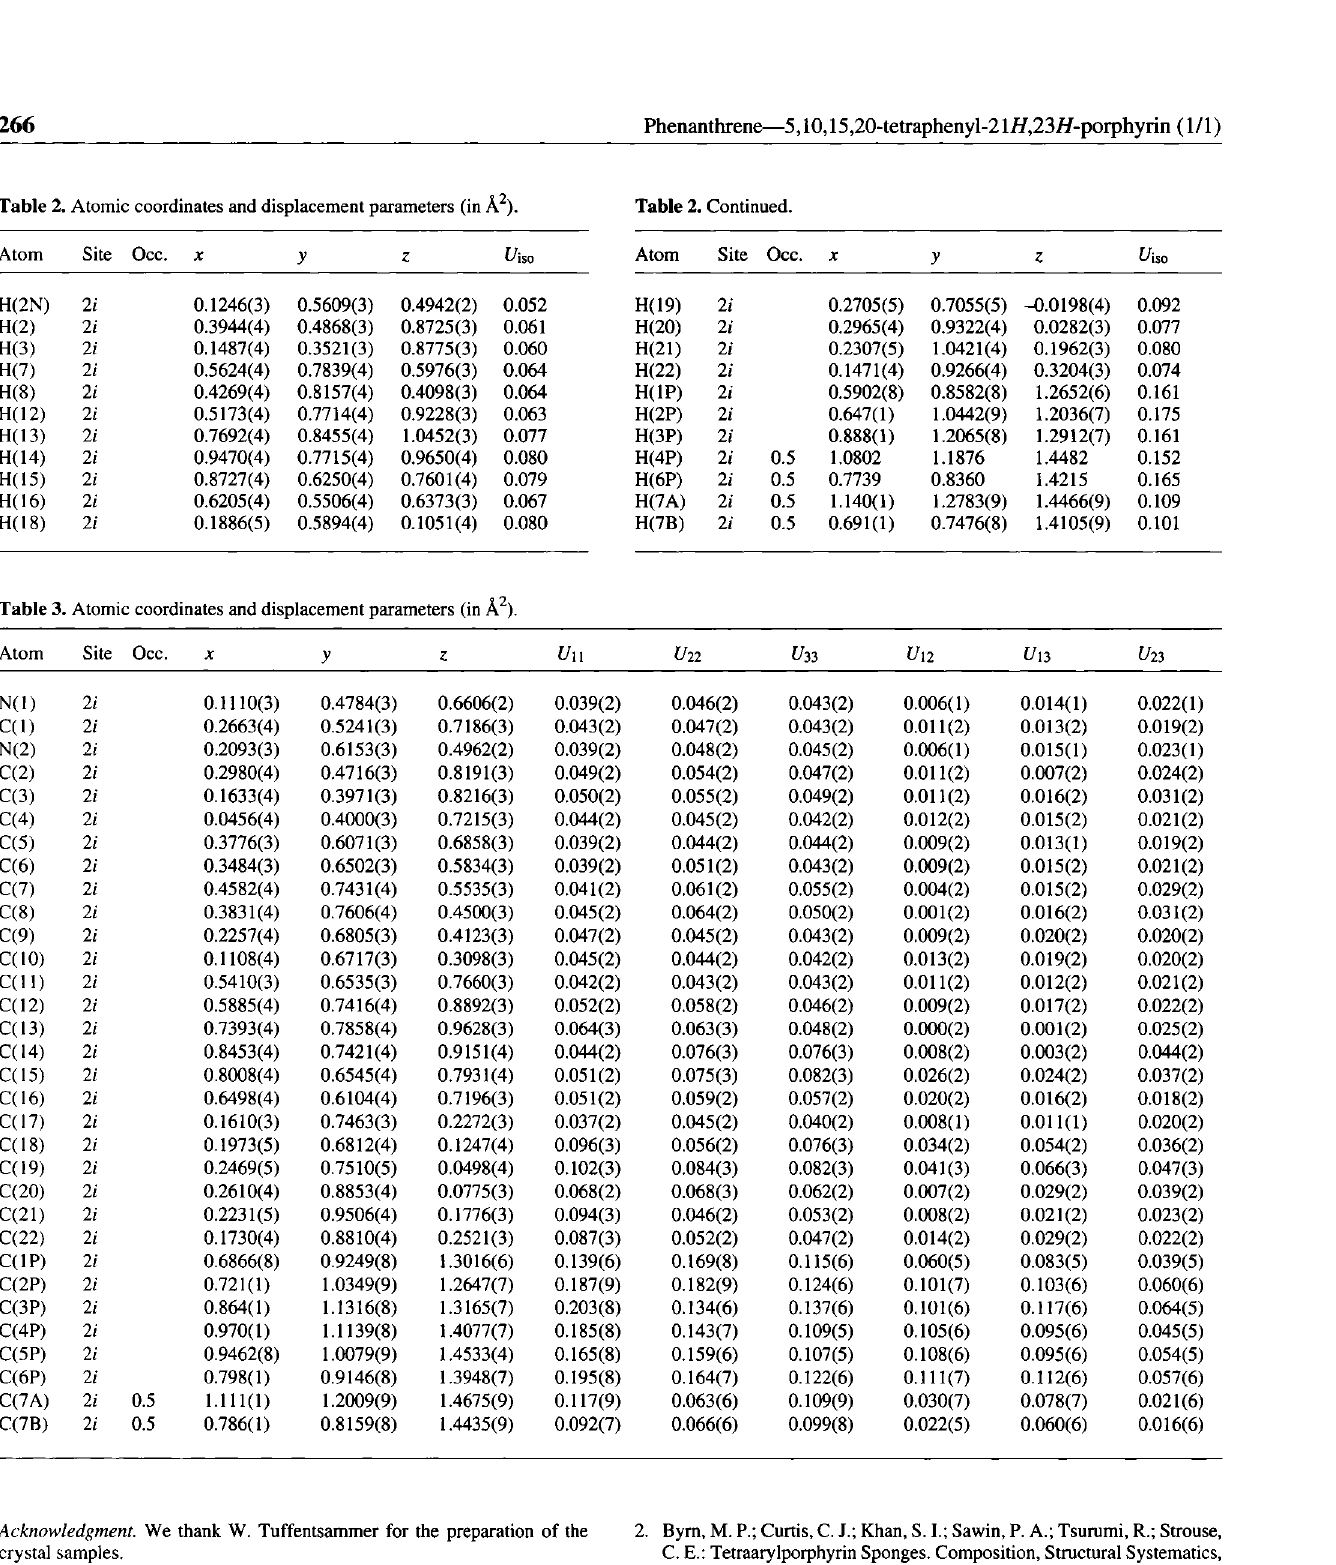
Table 2. Atomic coordinates and displacement parameters (in Ä 2 ). Atom Site Occ.